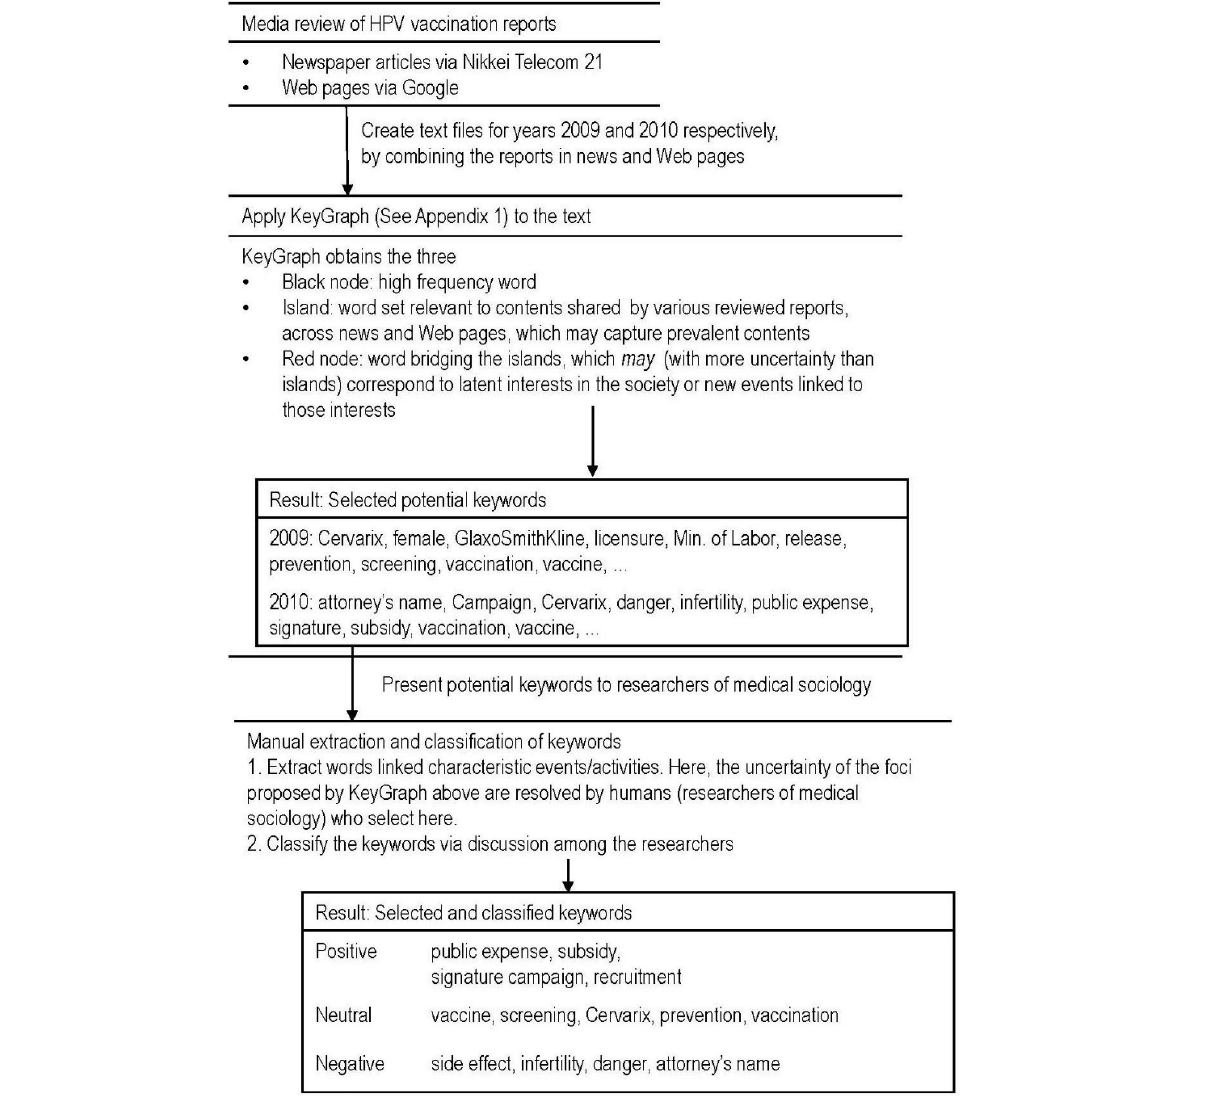
Figure 1. Overview of the process to analyze media review reports on HPV in